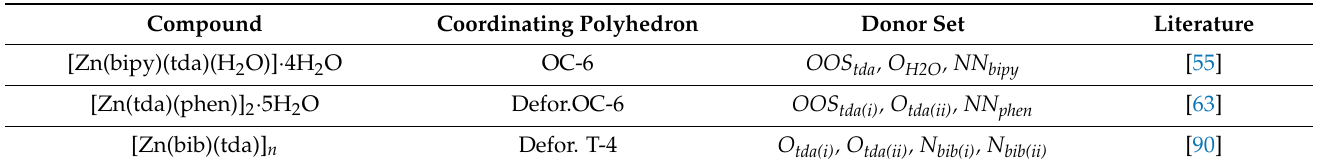
Table 5. Structurally characterized zinc complexes with thiodiacetic acid and N donor ligands.